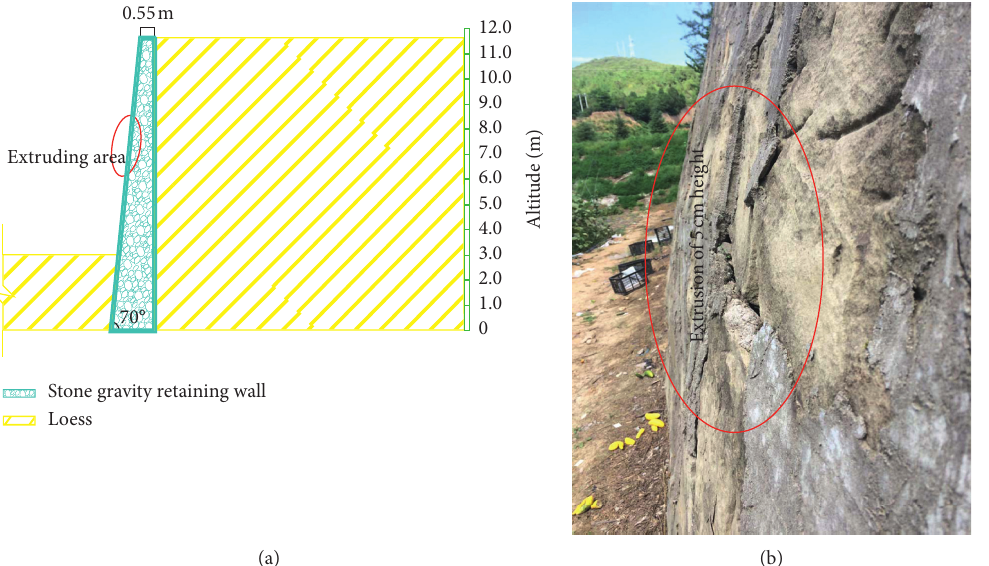
Figure 2: The slope prototype section with extrusion. (a) Prototype section. (b) Retaining wall